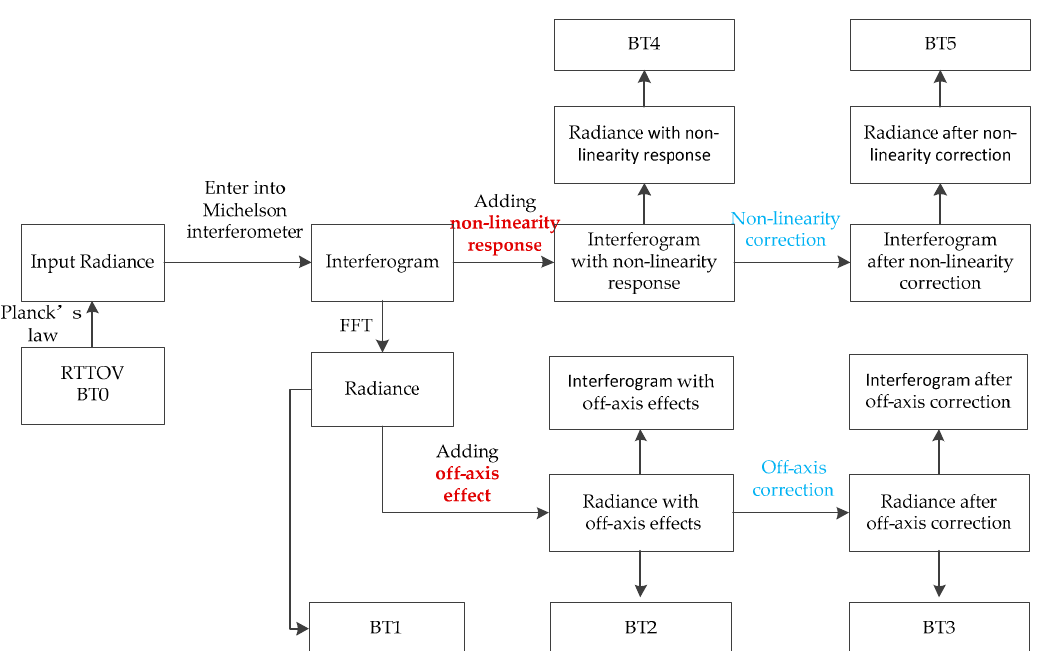
Figure 4 . Flow chart of the analysis of off-axis effects and the non-linearity response.